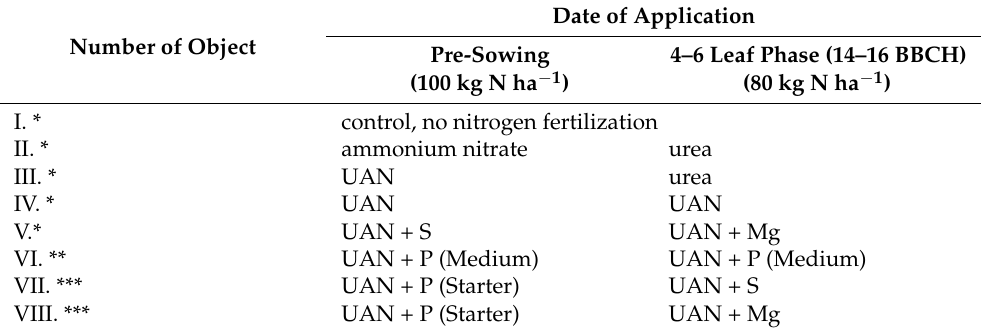
Table 1. Design of the